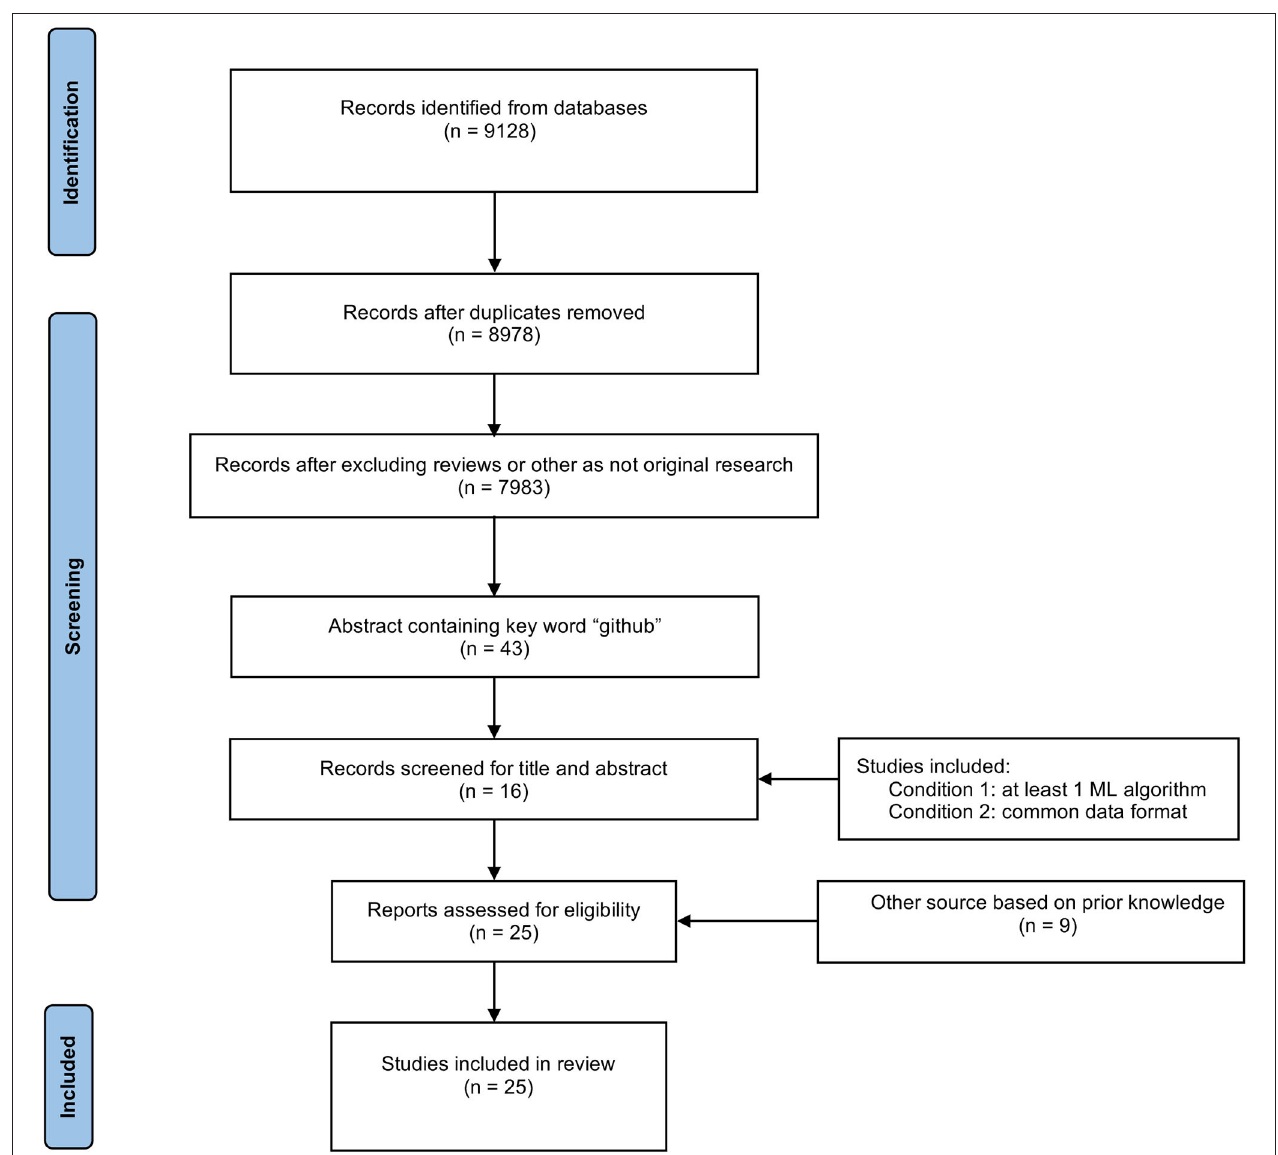
FIGURE 2 | PRISMA flowchart of the